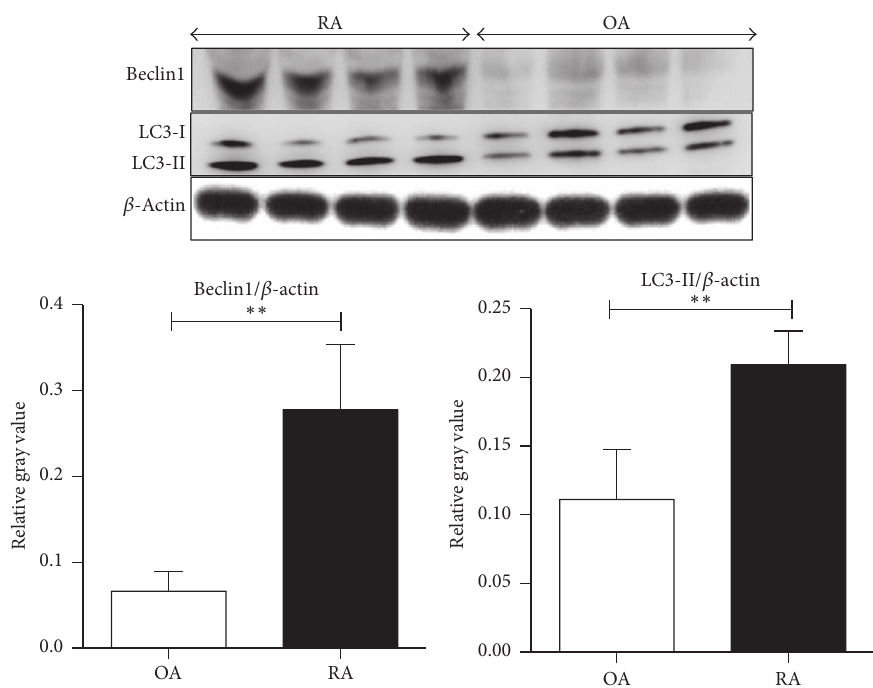
Figure 3: The autophagy-related proteins beclin1 and LC3-II show enhanced expression in RA and OA synovial tissues. Western blotting was used to determine the expression level of autophagy-related proteins beclin1 and LC3-II in RA and OA synovium. The expression of beclin1 and LC3-II was quantified, compared with the expression of